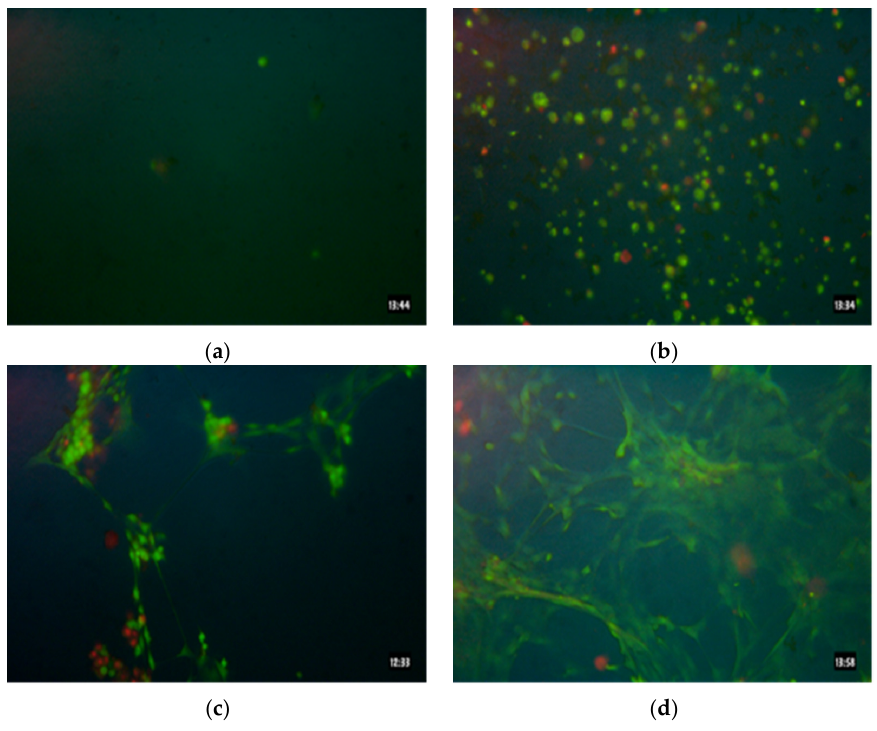
Figure 4. Cellular viability observed by LIVE/DEAD ® analysis on ( a ) GaAs; ( b ) GaAs ‐ ODT ( ‐ CH 3 ); ( c ) Si and ( d ) Si ‐ APTES (–NH 2 ) after 48 h (Bar represents 10 μ m).